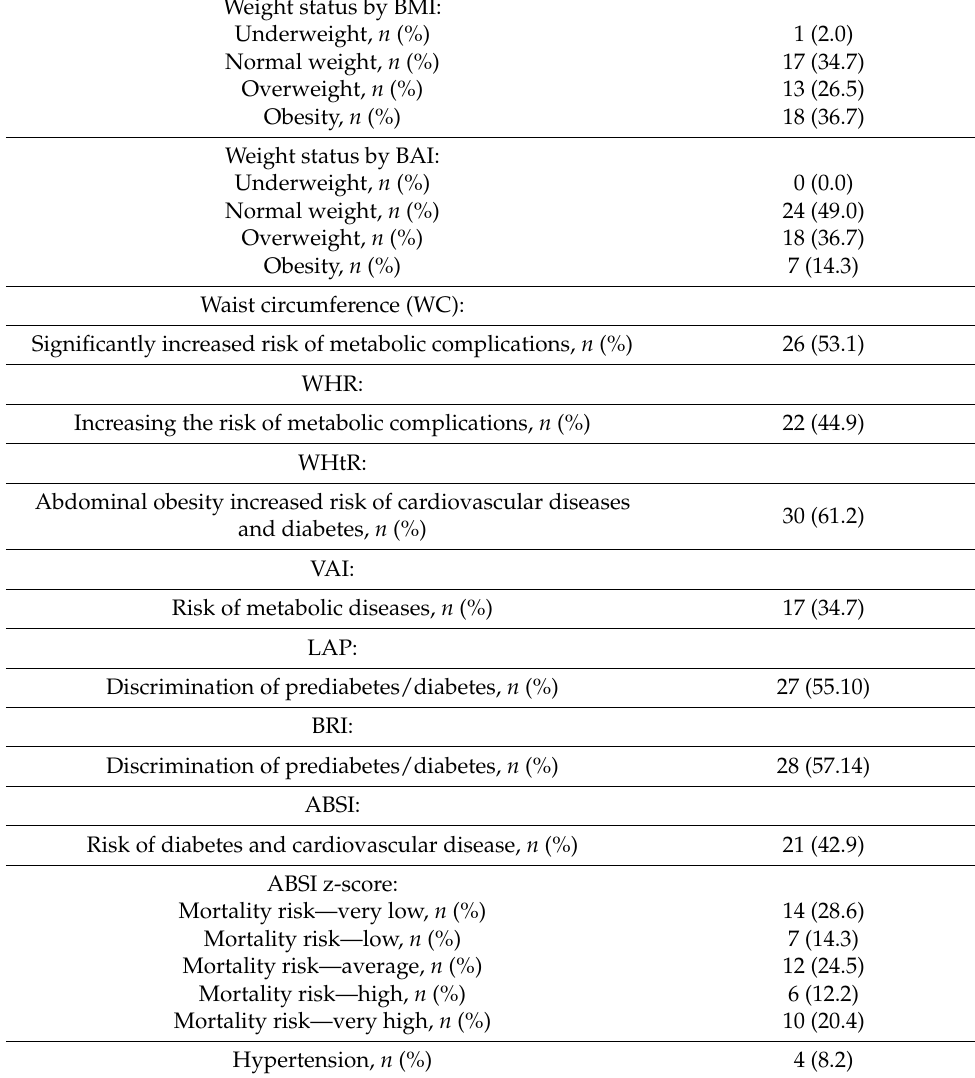
Table 4. Interpretation of anthropometric parameters and health status of the study